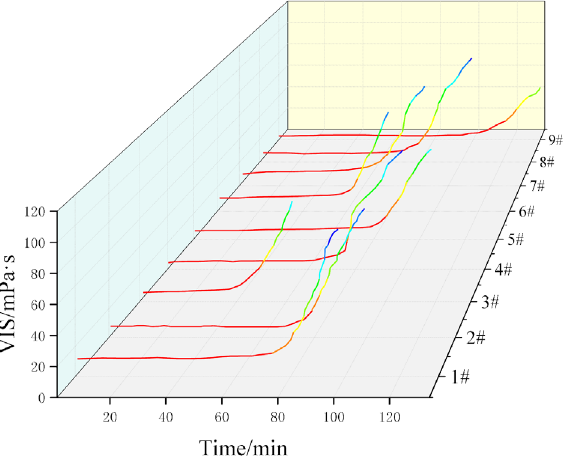
Figure 4. VIS time-varying curve.